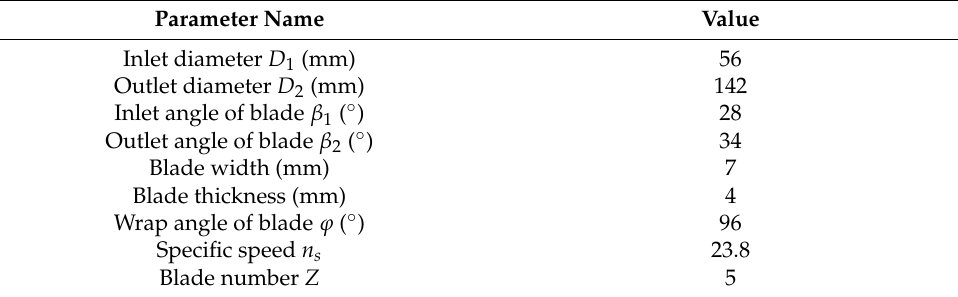
Figure 1. Outline of the test rig. Table 1. Main design parameters of the impeller.